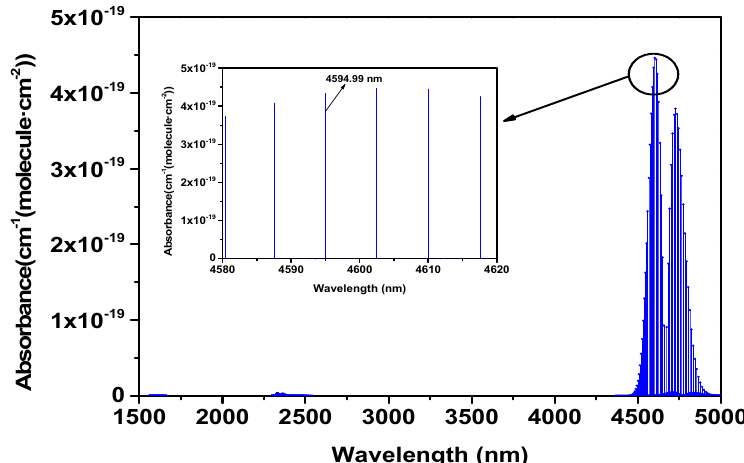
Figure 1. CO absorption lines in the range of 1.5–5 μ m.